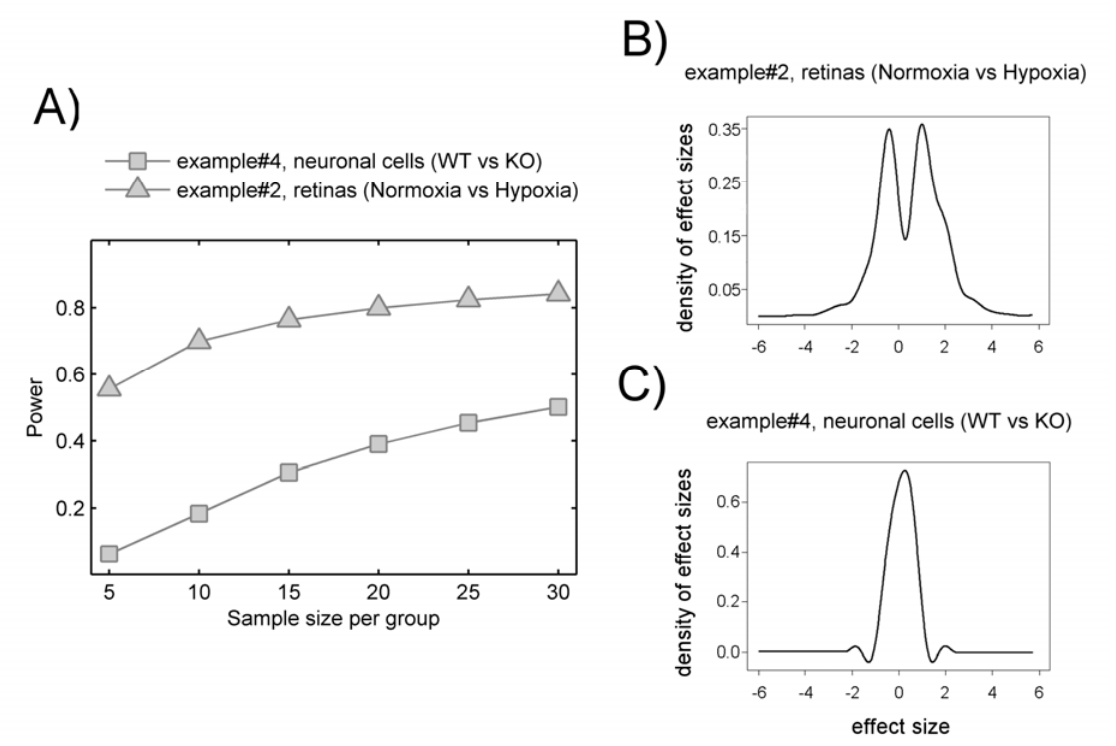
Figure 1. (A) Power curves for example #2 (  ) and example #4 ( (cid:0) ) with sample size on the x-axis and estimated power using 5% FDR on the y-axis. Estimated densities of effect sizes for example #4 (B) and example #2 (C) with the standardized effect size on x-axis and estimated densities on the y-axis. Bimodal densities as in example #2 reflect more pronounced